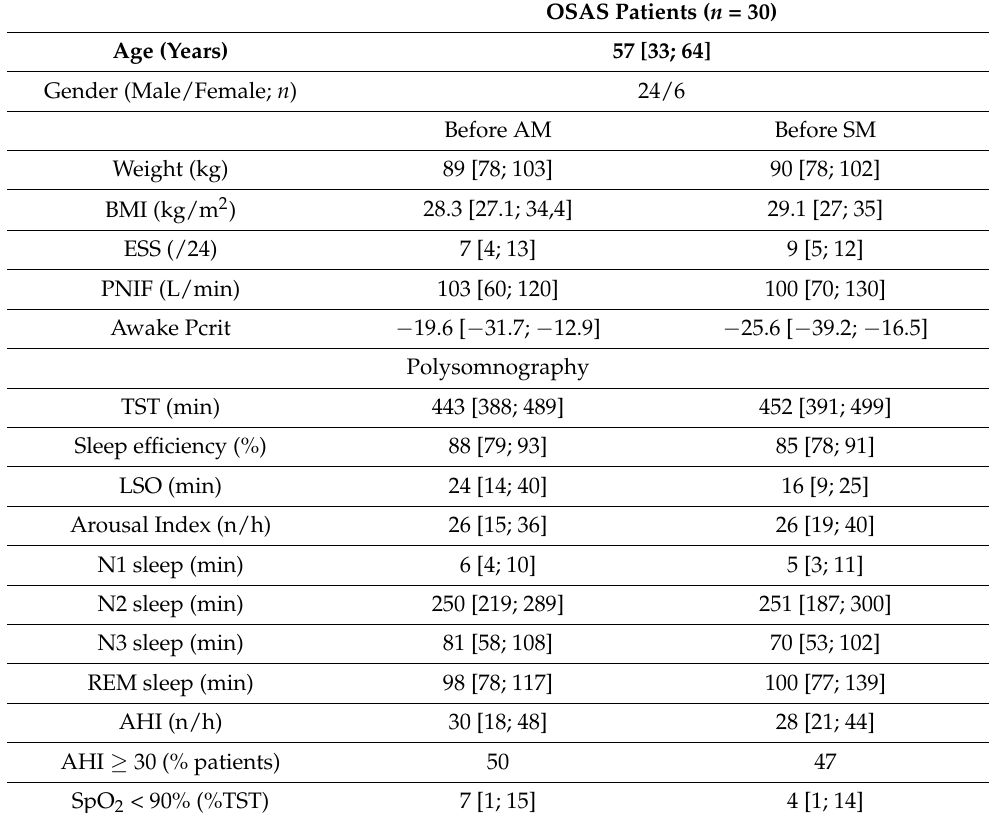
Table 1. Baseline data before active manual stimulation of the sphenopalatine ganglion and before sham manual stimulation.